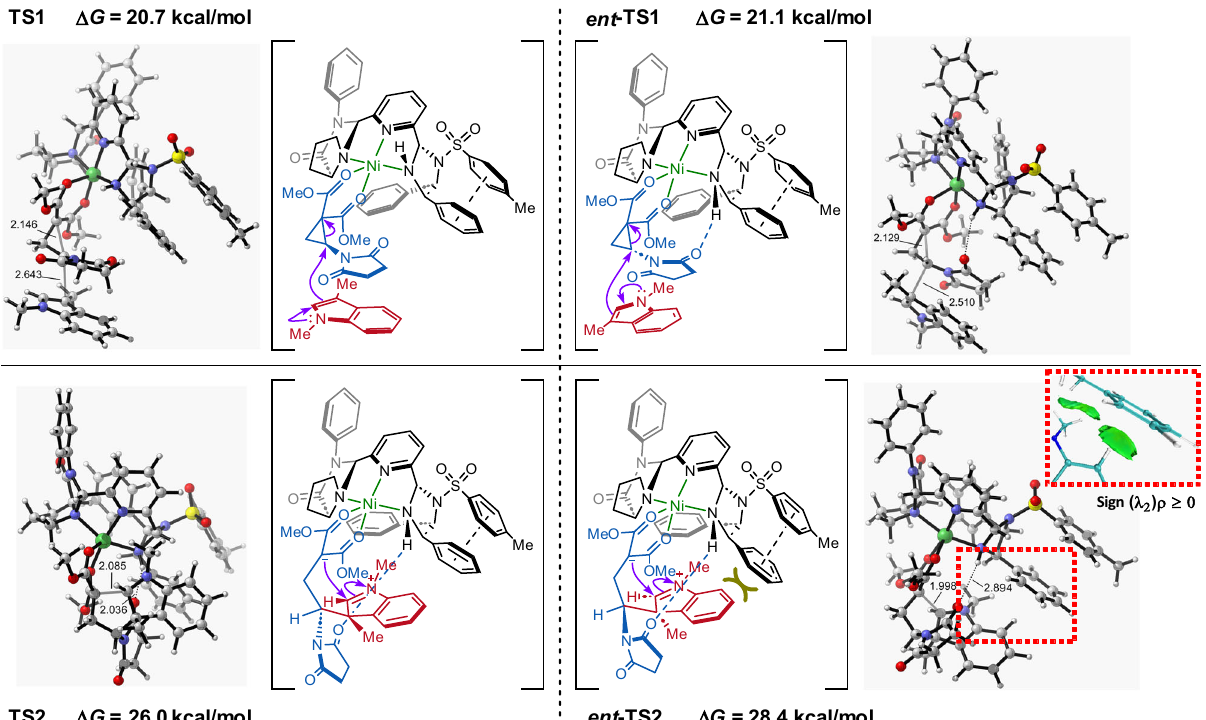
Fig. 8 | Stereocontrol mechanism. DFT-optimized structures (bond lengths, Å) and relative free energies ( Δ G , kcal/mol) of enantio-determining transition states at the M06-2X-D3/Def2-TZVP/SMD(DCM)//M06-2X-D3/Def2-SVP level of